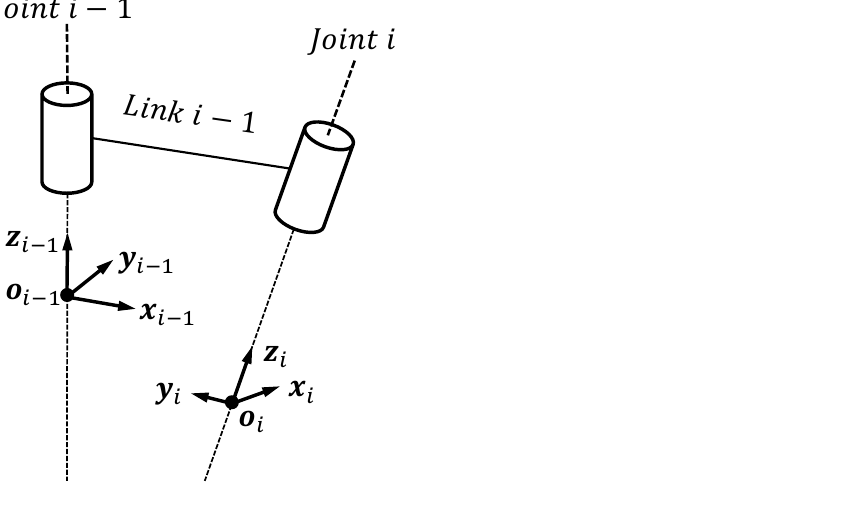
Figure 1. A frame { o , x , y , z } is attached to each joint of the serial robot to describe its relative position and